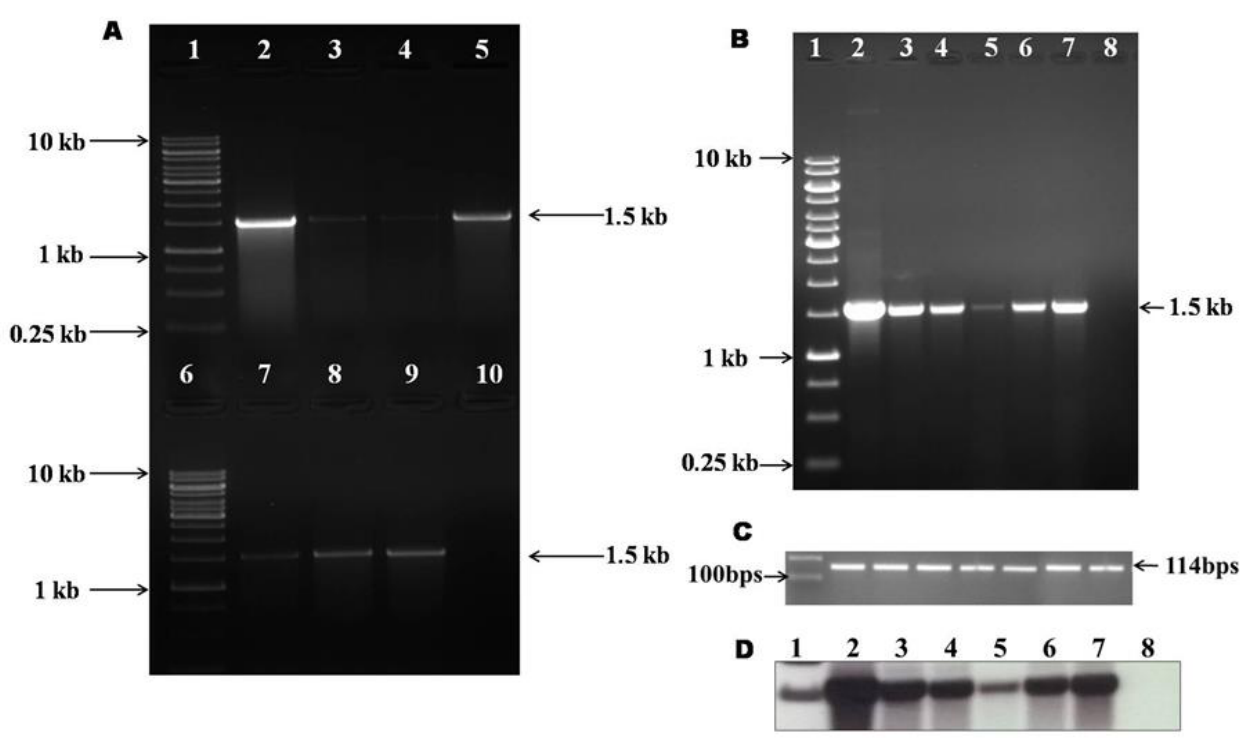
Figure 3. Confirmation of transgene integration. ( A ) PCR confirmation of GmIFS expression in in vitro grown onion calli. Lane 1,6: 1 kb DNA marker, Lane 2,7: Positive control (plasmid), Lane 3–5: Agrobacterium -mediated transformed callus, Lane 8–9: Biolistic-mediated transformed callus, Lane 10: Negative control (wild type callus); ( B ) Reverse transcriptase PCR showing the expression of GmIFS in stable transgenic callus; ( C ) β-Actin internal control; ( D ) Confirmation of gene integration by Southern hybridization. Lane 1: 1 kb DNA marker, Lane 2: Positive control (plasmid), Lane 3–5: Agrobacterium transformed callus, Lane 6–7: Gene gun transformed callus, Lane 8: Negative control (wild type callus).